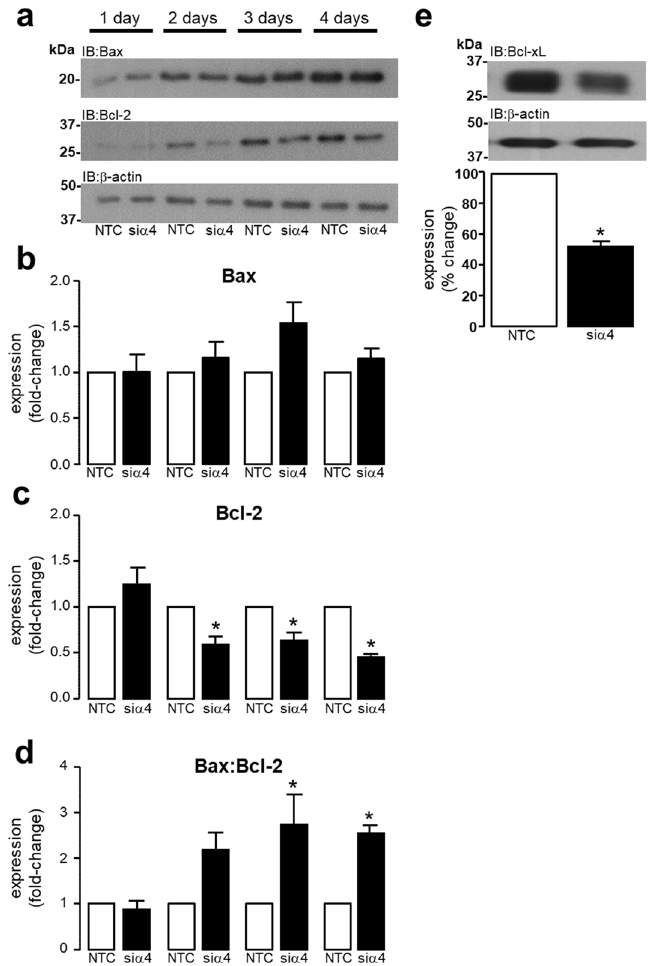
Figure 4. Alpha4 protein knockdown alters expression of BCL-2 family of pro- and anti-apoptotic proteins. H9c2 cardiomyocytes were transfected with either 50 nM non-targeting control (NTC) siRNA or 50 nM siRNA specific to rat α4 protein (siα4) for 1–4 days. The expression of Bax and Bcl-2 protein was determined by Western analysis using antibodies raised against human Bax and Bcl-2 protein ( a ). Quantification of Bax ( b ) and Bcl-2 ( c ) protein expression was determined by densitometry. The Bax:Bcl-2 ratio was calculated by dividing the Bax signal by the Bcl-2 signal ( d ). The expression of Bcl-xL was determined by Western analysis using an antibody raised against human Bcl-xL, in H9c2 cardiomyocytes transfected with either 50 nM non-targeting control (NTC) siRNA or 50 nM siRNA specific to rat α4 protein (siα4) for 4 days ( e ). Where appropriate, statistical significance was determined either by a one-tailed Student’s T-test or by ANOVA followed by a multiple comparison Tukey’s modified test. All data represents mean values ± SEM of 5 individual experiments. Expression of β-actin was used to confirm equal protein loading between